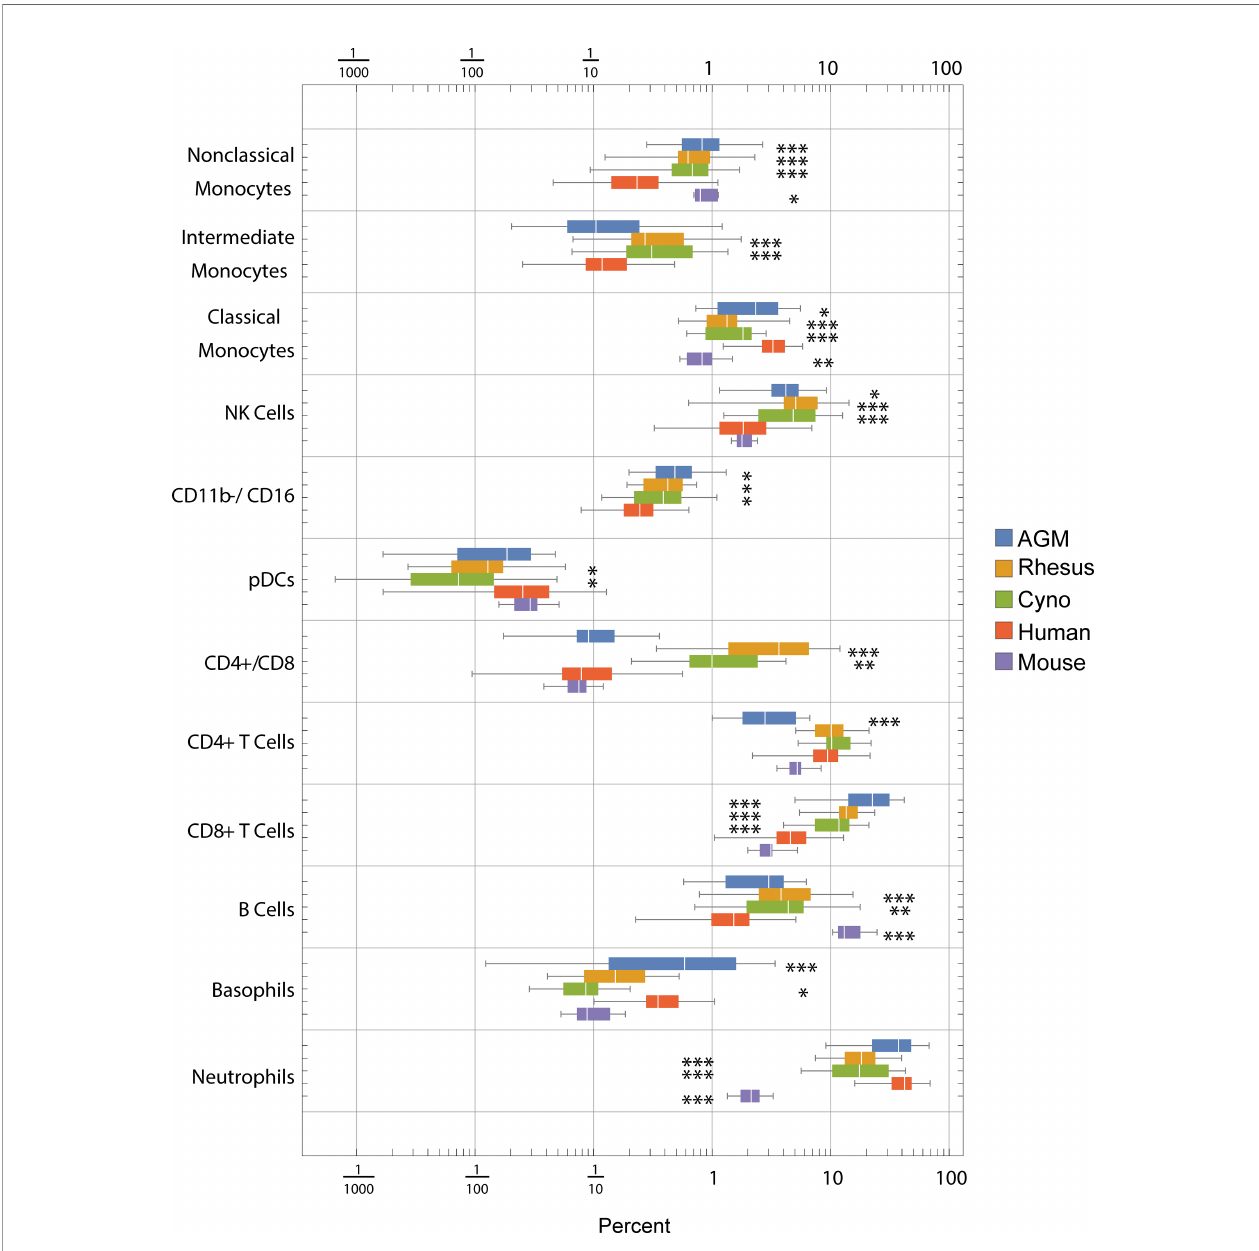
FIGURE 2 | Frequencies (percent of total) of gated cell types by species. Center line: median; Box: 25th to 75th quantile; Whiskers: 1.5x interquartile range. Statistics: ANOVA with Bonferroni post-test was calculated for each population. Asterisks indicate species that are signi fi cantly different from humans *p < 5x10 -2 , **p < 1x10 -2 , ***p < 1x10 -3 after Bonferroni